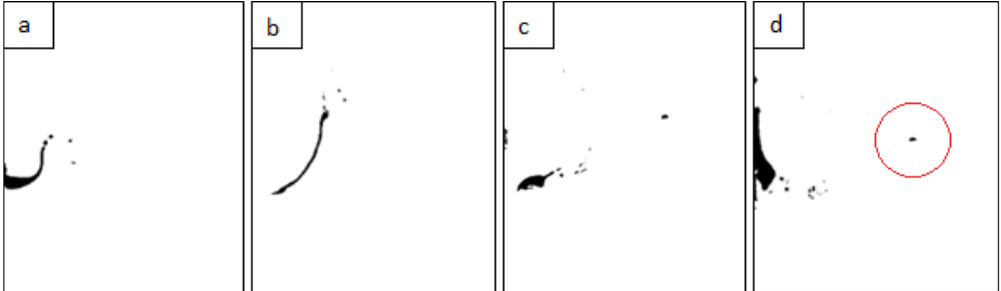
Figure 12. Simulation of the behaviour of a petrol drop causing a splash phenomenon in an immiscible fluid system: ( a ) spilling petrol drop on the inside of the crown and cavity, t = 1.8 ms; ( b ) petrol droplets detaching from the rim of the crown, t = 16.1 ms; ( c ) re-collection of most of the petrol to the impact centre, t = 26.7 ms; ( d ) the formation of the petrol into a secondary splash form, the so-called jet, t = 33.9 ms. The red circle marks the petrol droplet that detached from the crown spike and landed farthest from the centre of the impact.